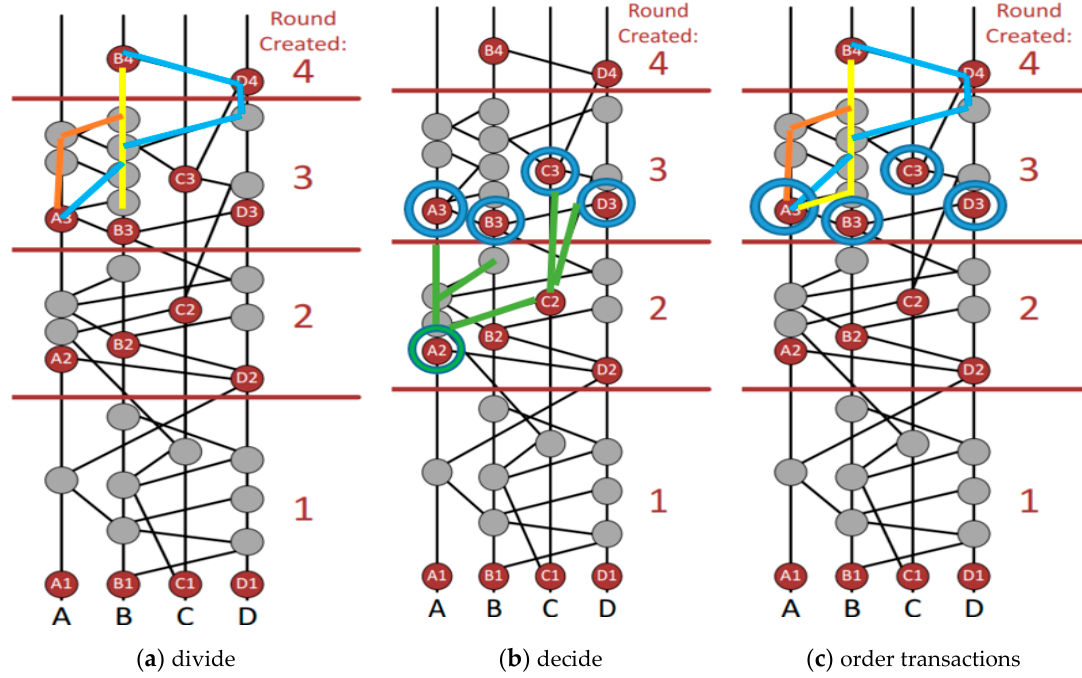
Figure 5. Round creation in hashgraph.